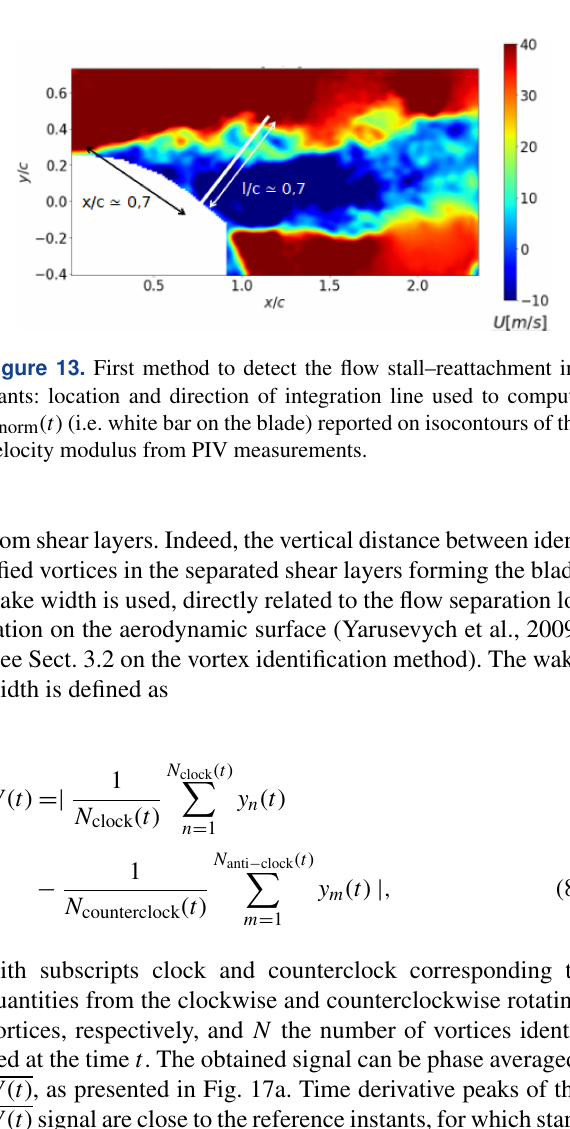
Figure 12. Strouhal number values extracted from Yarusevych et al. (2009) and from the FFT of the temporal mode, a 2 ( t ), of the POD decomposition.